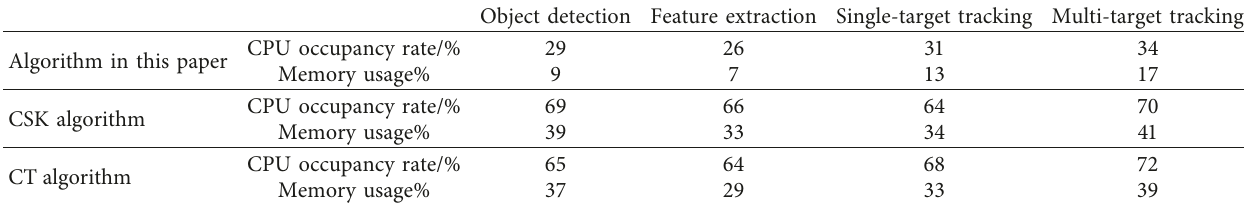
Table 7: Resource occupancy ratio of different platforms/%. CPU occupancy Algorithm in this paper